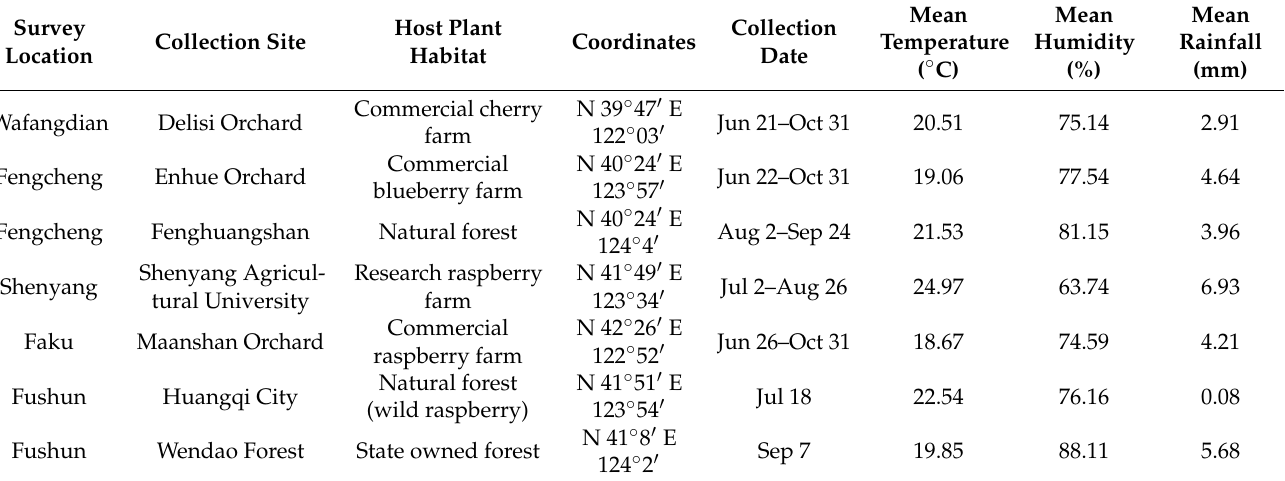
Table 1. Sampling locations and sites for D. suzukii and its parasitoids in 2016 Liaoning, China.